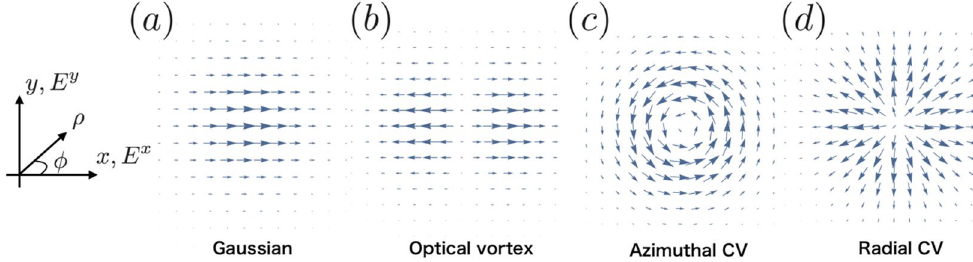
Figure 2. Snapshots of the in-plane ( x and y ) components of the electric field of ( a ) linearly polarized Gaussian beam, ( b ) linearly polarized Optical vortex with unit orbital angular momentum, ( c ) azimuthal CV beam, and ( d ) radial CV beam. The field amplitude of the Gaussian beam is the strongest at the center while beams ( b – d ) have vanishing in-plane components there due to their topological nature. The size of the arrows in the figure corresponds to the laser amplitude at each point. We show the definition of ρ φ ( , ) in the cylindrical coordinate for later use.